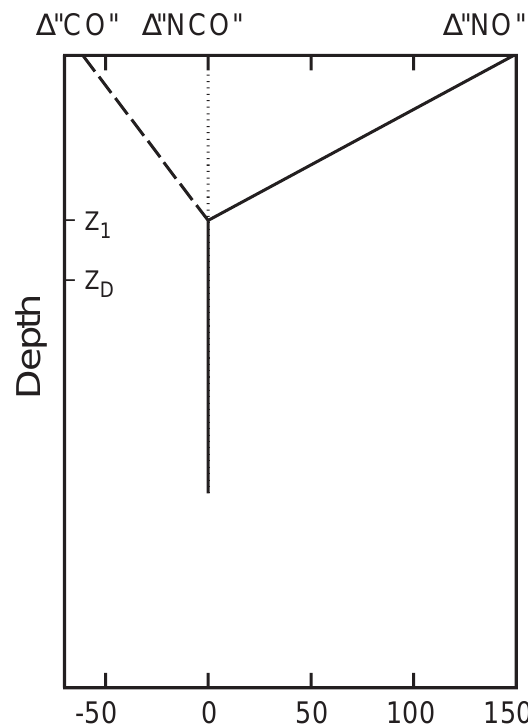
F IG . 1. – Theoretical plot of anomalies in “NO” and “CO” produced by excess carbohydrate synthesis, also plotting the conservative tracer “NCO”. Z is the depth of the region of nutrient depletion; Z 1